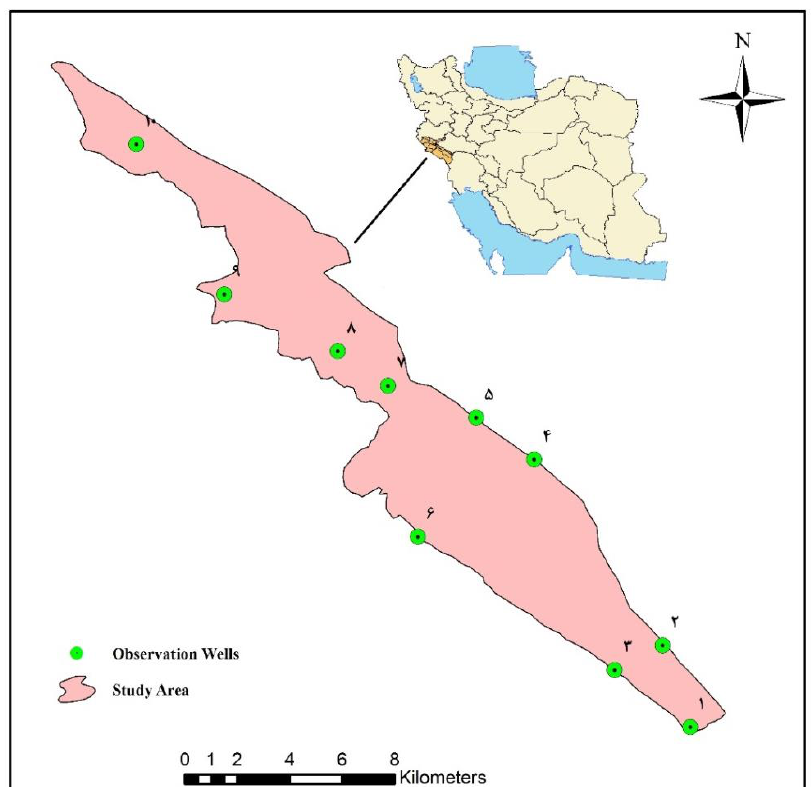
Figure1. Location map of the study area and sampling